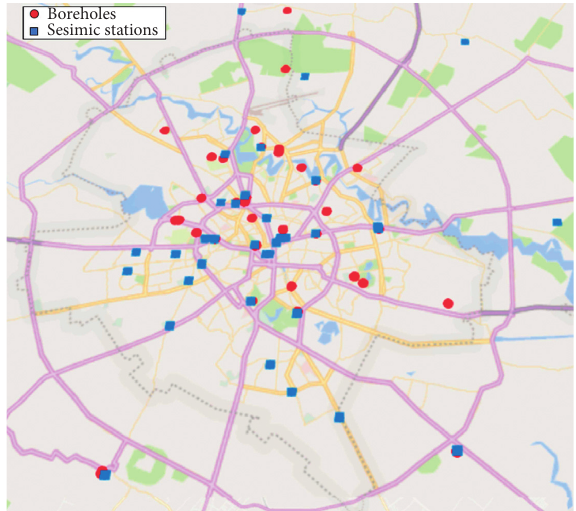
Figure 11: Position of boreholes and of seismic stations in Bucharest area used in this